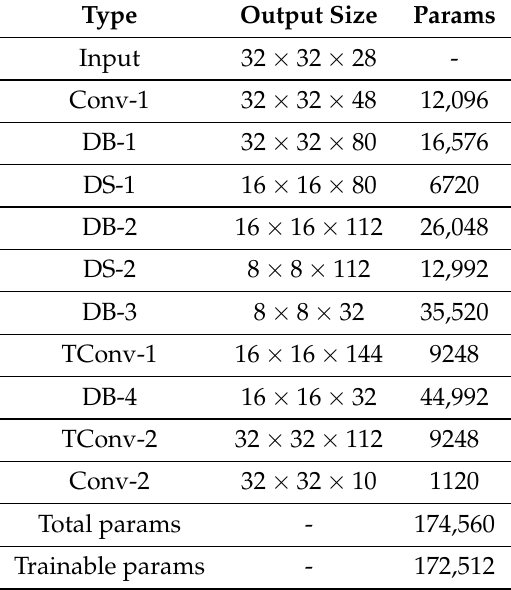
Table 3. Architecture details of the FCNpixel model. k corresponds to the number of feature maps. d stands for the input channels, and c stands for the number of classes. TConv, Transposed